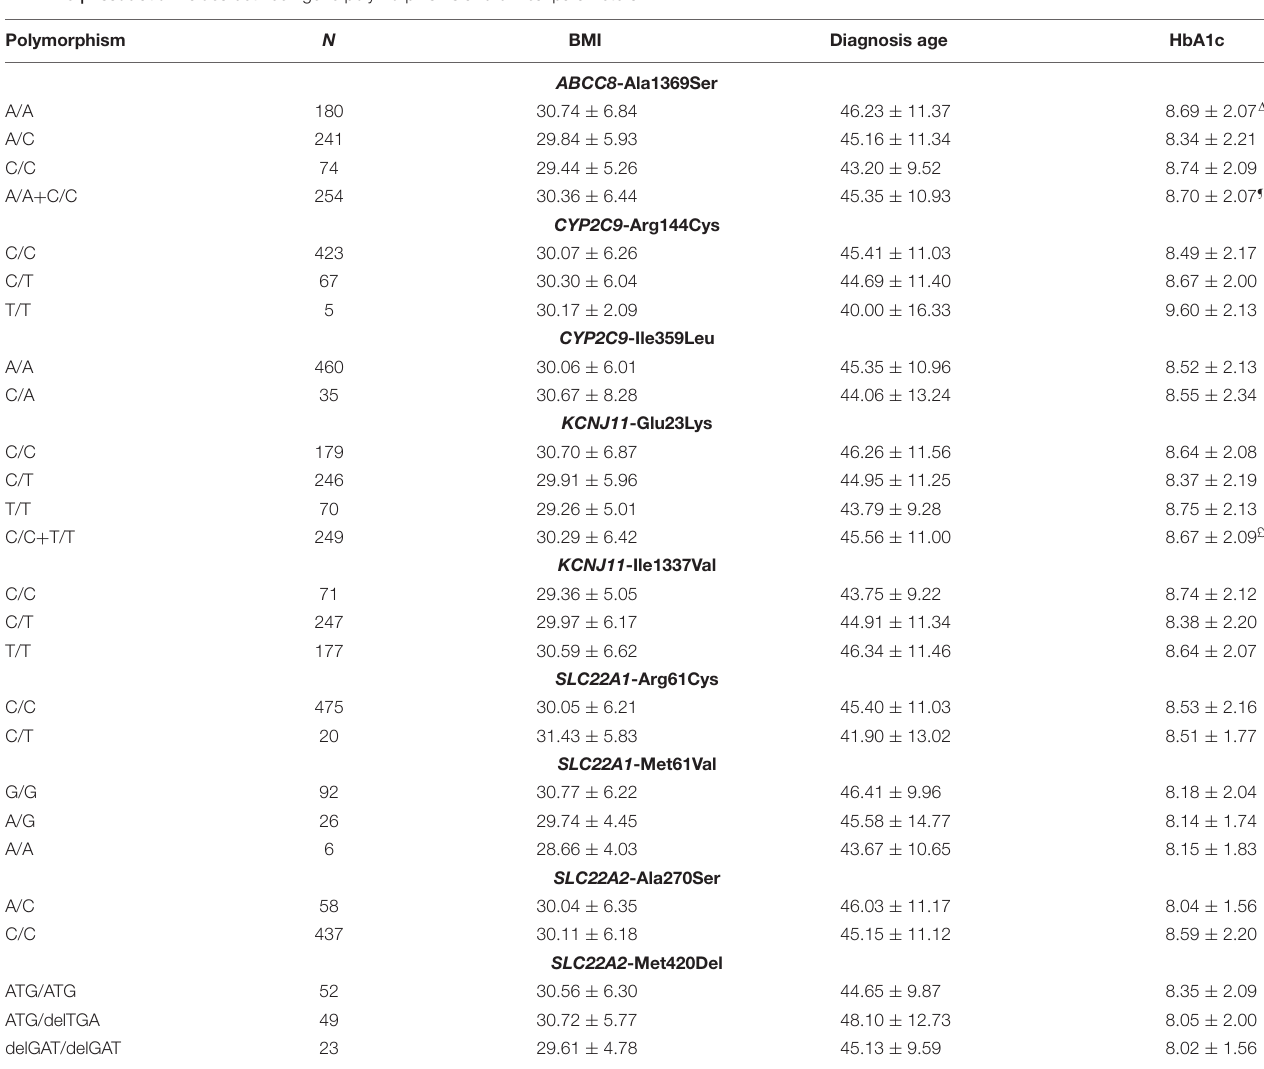
TABLE 3 | Association values between gene polymorphisms and clinical